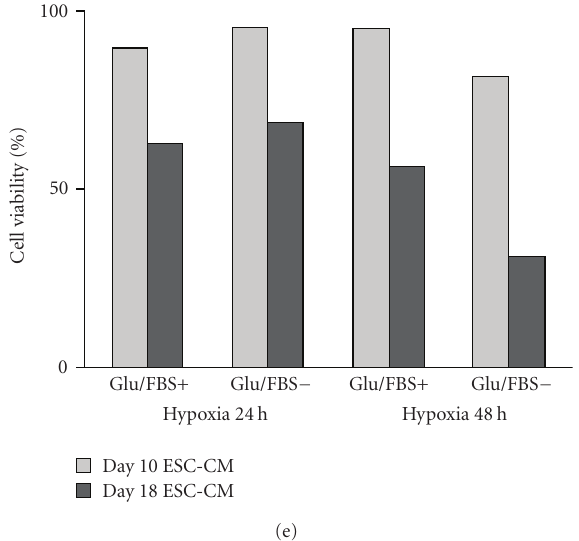
Figure 2: Characterization of immature syNP4 ES cell derived-CMs. (a) The purity and maturity of ESC-CMs at Day 11 were estimated by costaining with anti- α -SMA (red) and anti- α -actinin (sarcomeric) (green) antibodies. All cells express α -SMA, while 90 ± 2% cells are α -actinin positive. The right figure is a high magnification of the box in the left one. Arrows mark cells with α -SMA positive and α -actinin negative staining. (b) The DNA content of puromycin-selected ESC-CMs generated by mass culture was determined following PI staining. In these experiments ( n = 3), the histogram indicates that Day 9 cells contain a higher percentage of G2/M phase cells than Day 14 cells. The number of G0/G1 cells also tends to increase with time of di ff erentiation ( P > 0 . 05). (c) Relative to controls, immature ESC-CMs incubated with 1.5 μ M Jc1 had a strong increase in red fluorescence, which based on membrane potentials is indicative of live cells. Moreover, lack of change in membrane potential in either cell population indicates that the data shown from the MTG assay is directly comparable. (d) Typical results from MTG-stained cells assessed by flow cytometry. The green fluorescence signal is directly proportional to the mitochondrial content. As shown in the figure and table, the mitochondrial content increases with time of di ff erentiation. (e) Cell viability of ESC-CMs cultivated under hypoxic and nutrient deprivation conditions. Data are presented as a percentage of control